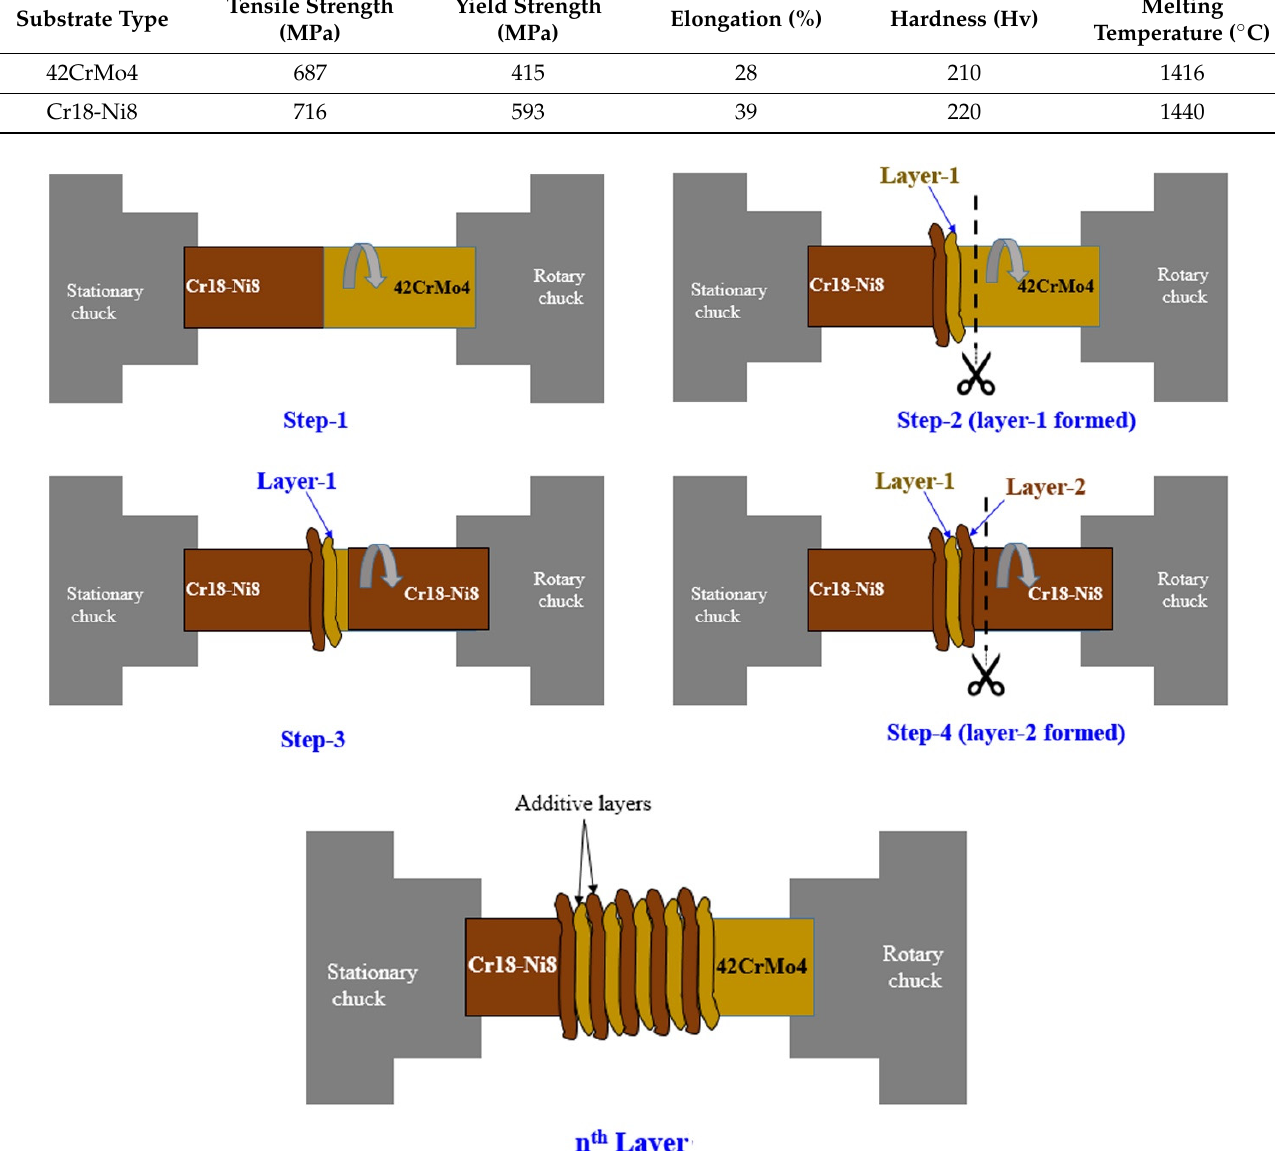
Table 2. Chemical composition (wt.%) of the substrates used for additive manufacturing .